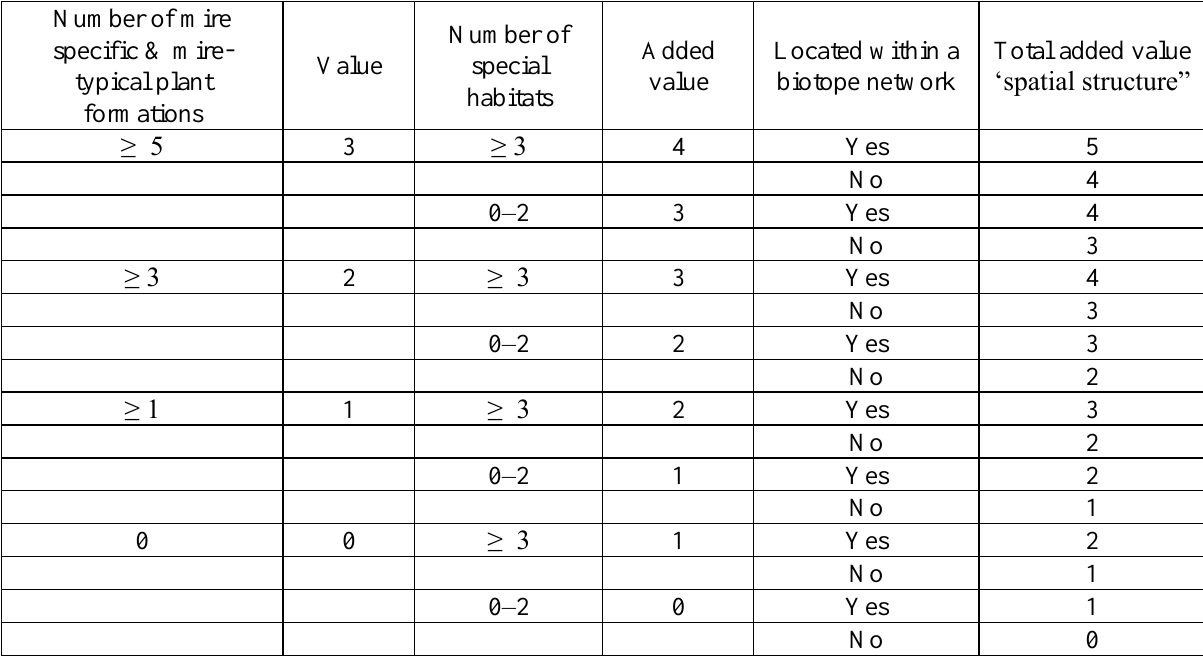
Table 9. Value scale for the indicator ‘spatial structure’ based on number of mire-specific and mire-typical plant formations, number of special habitats and integration into biotope network (biocoenosis diversity).